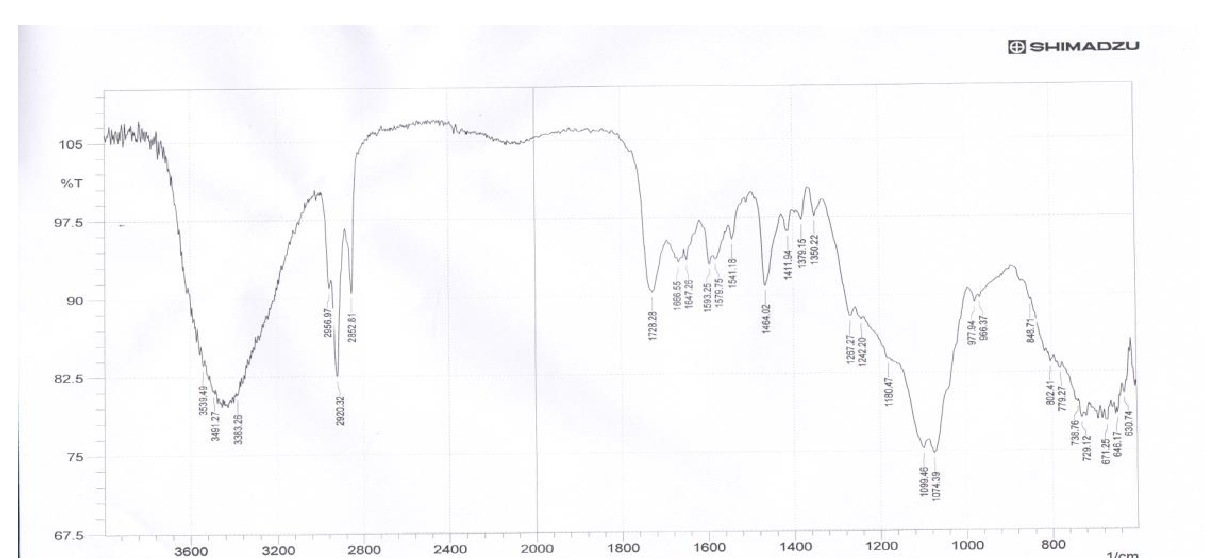
Figure 11. FTIR spectrum of isolated S compound Melting